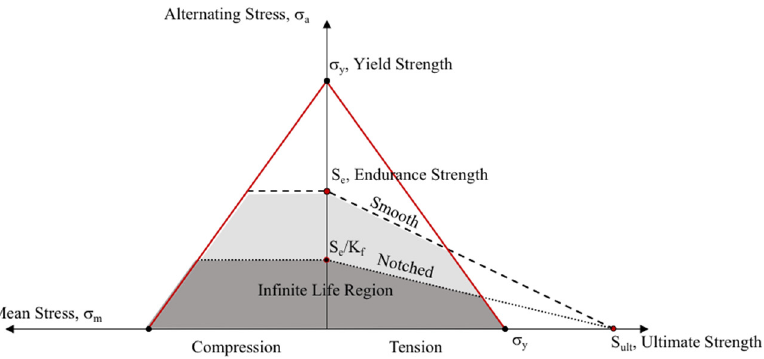
Figure 24. Constant life diagram using the modified Goodman criteria for smooth and notched spec- imens.